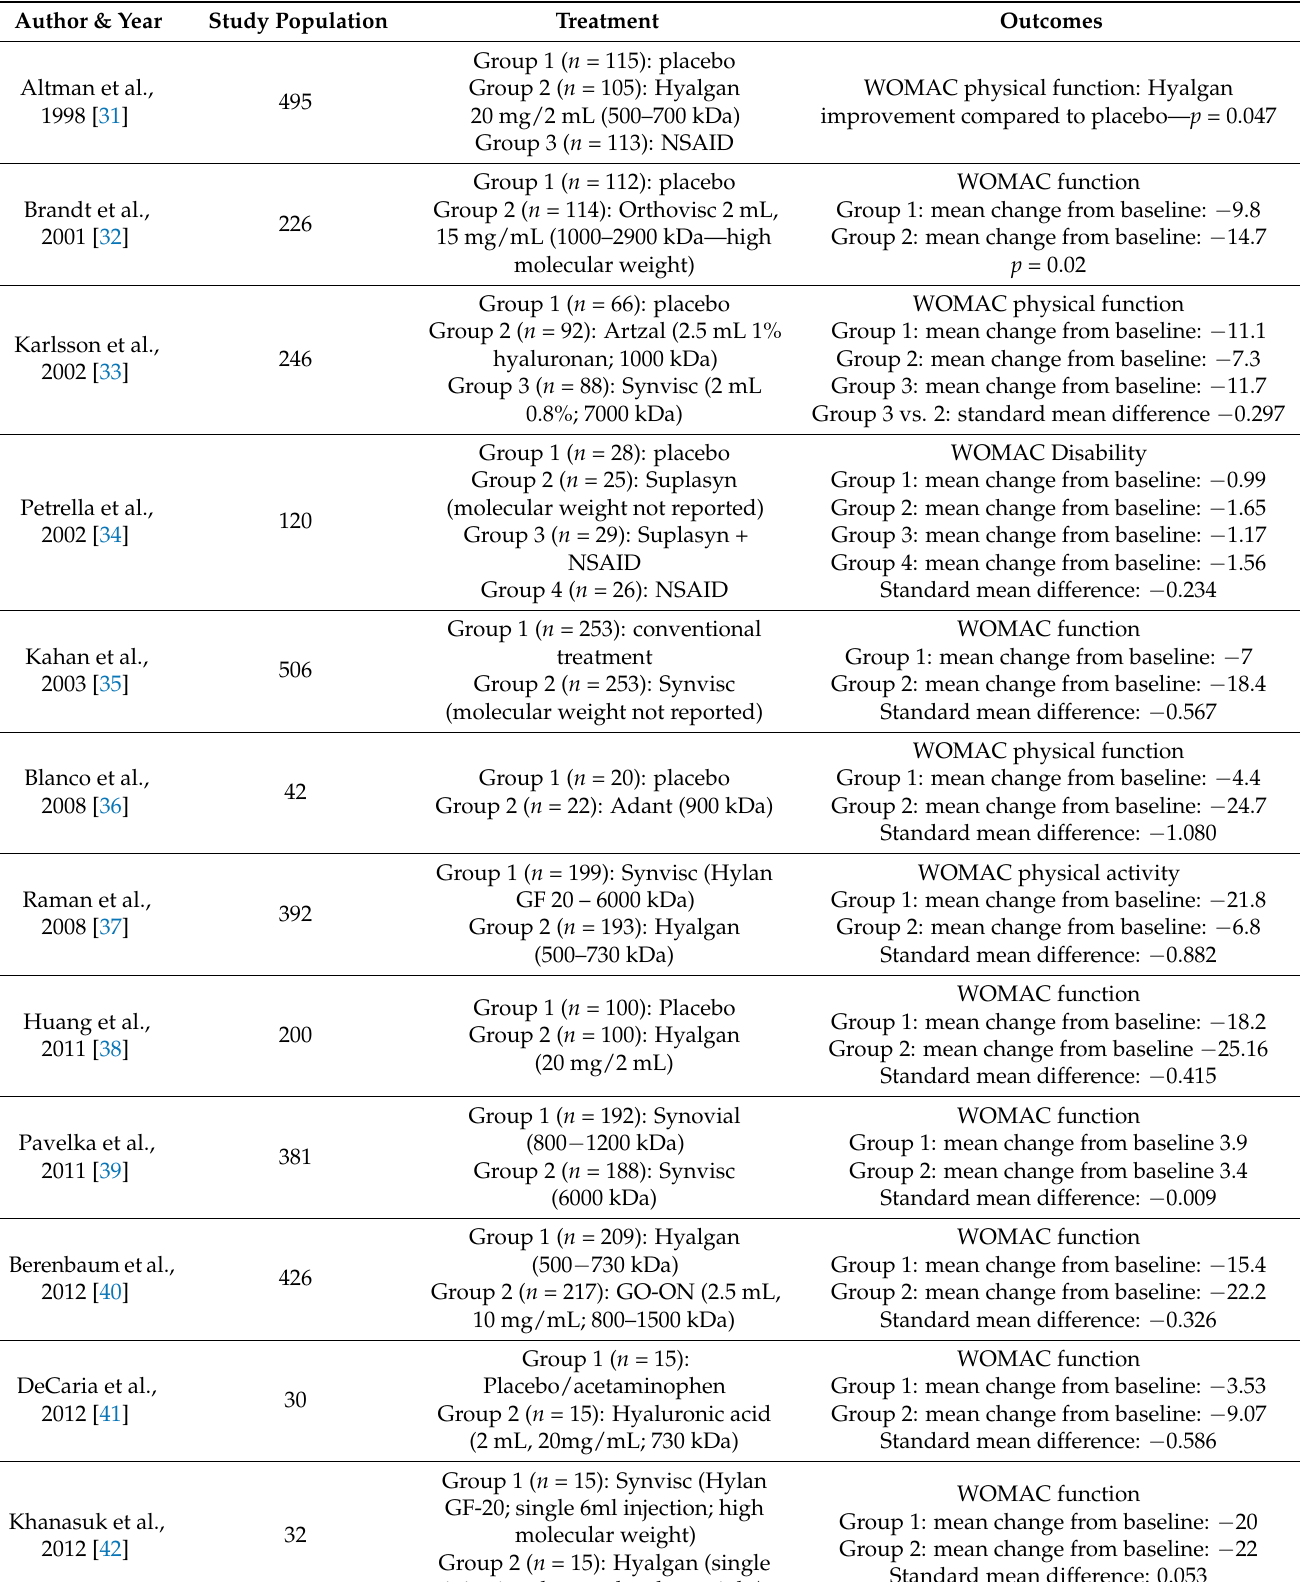
Table 2. Published papers (1998–2012) regarding HA injections in knee OA treatment with outcomes measured by WOMAC